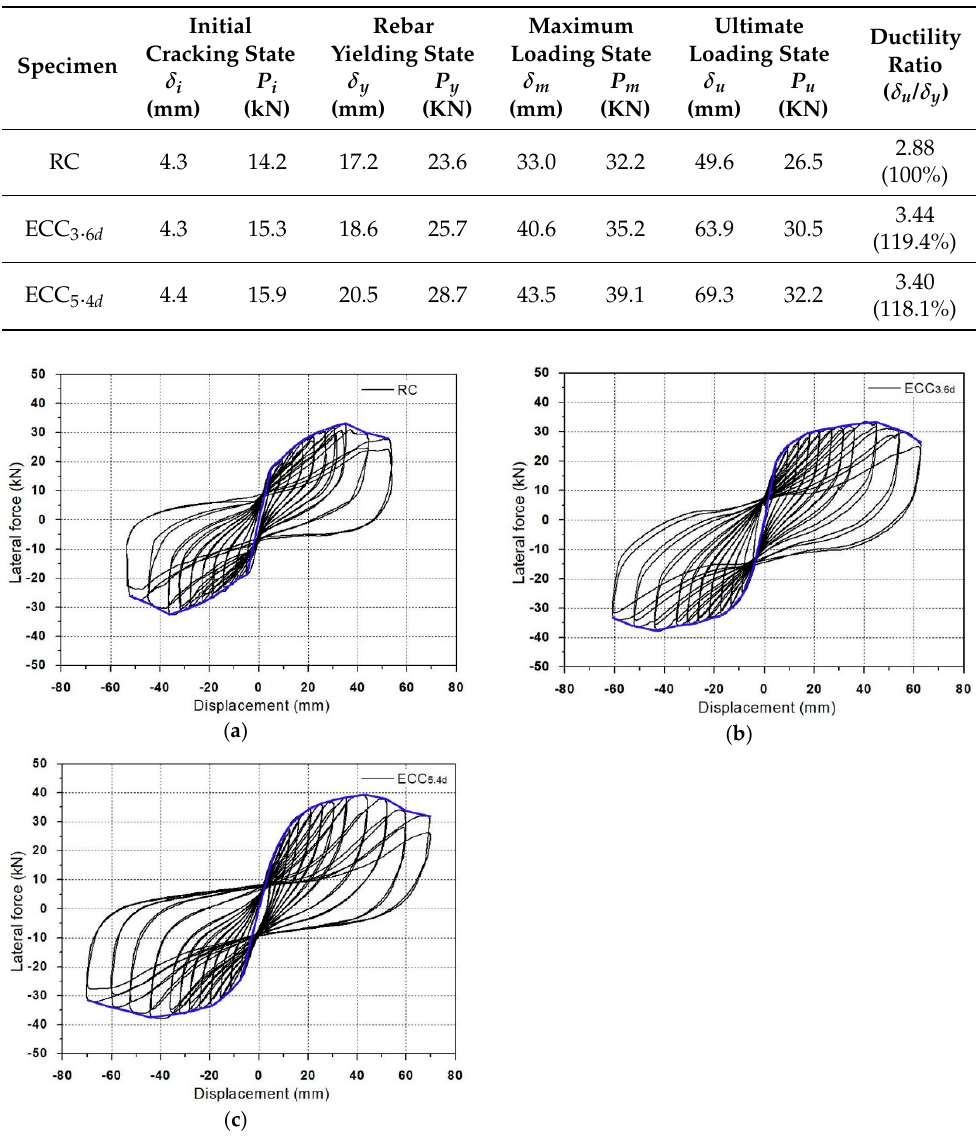
Table 5. Result of repeated loading test under the positive force condition.